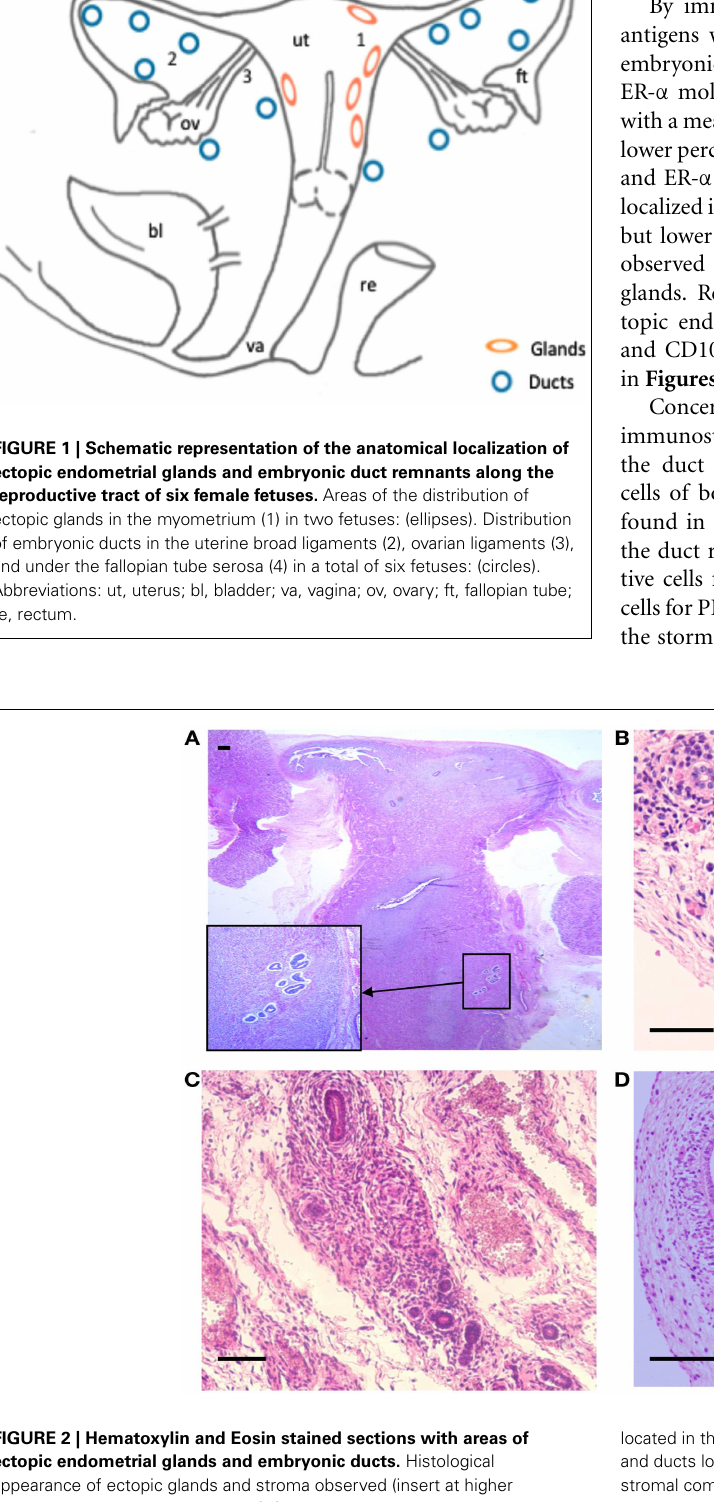
located in the broad ligament (B) , under the fallopian tube serosa (C) , and ducts located in the ovarian ligament (D) . Note presence of a stromal component surrounding the duct residues in (A–D) . Scale bars, 100 µ